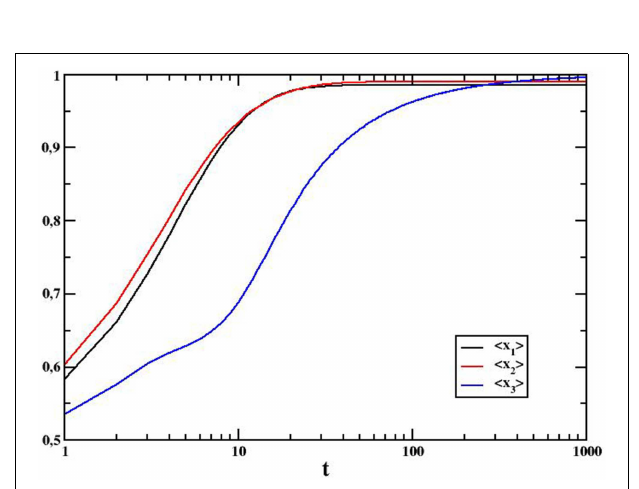
FIGURE 7 | Time behavior of the average internal variables for a system of N = 100 on a totally connected graph and initial average opinion h O 0 i = 0 . 5 ; continuous opinion. Averages over 2000 independent realizations.